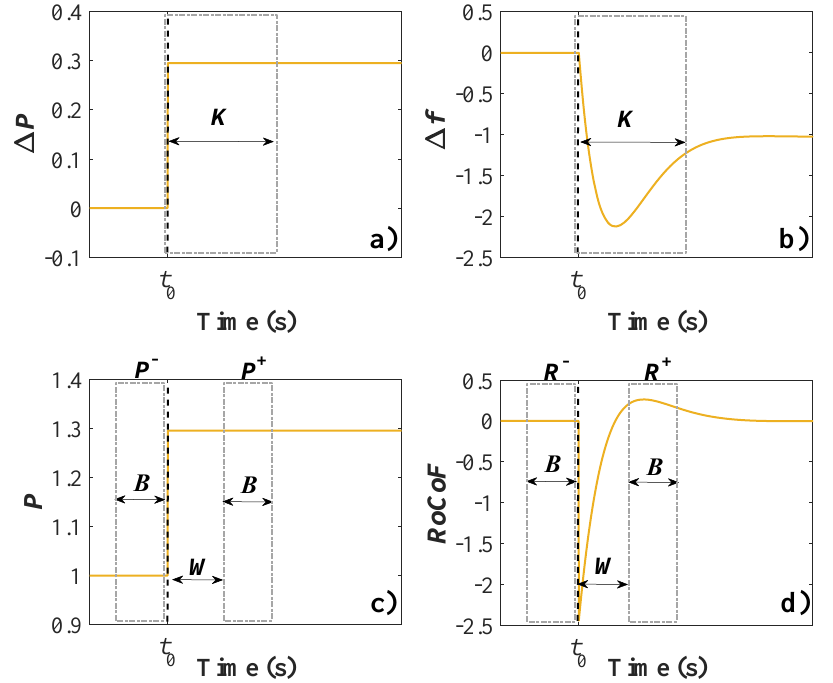
Figure 1. Indicative set of transient responses used for inertia estimation. ( a ) Active power deviation (in p.u.). ( b ) Frequency deviation (in p.u.). ( c ) Active power response (in p.u.). ( d ) RoCoF (in p.u./s). These indicative responses were generated using the SFRM proposed in [103]. Parameters for the SFRM are given in